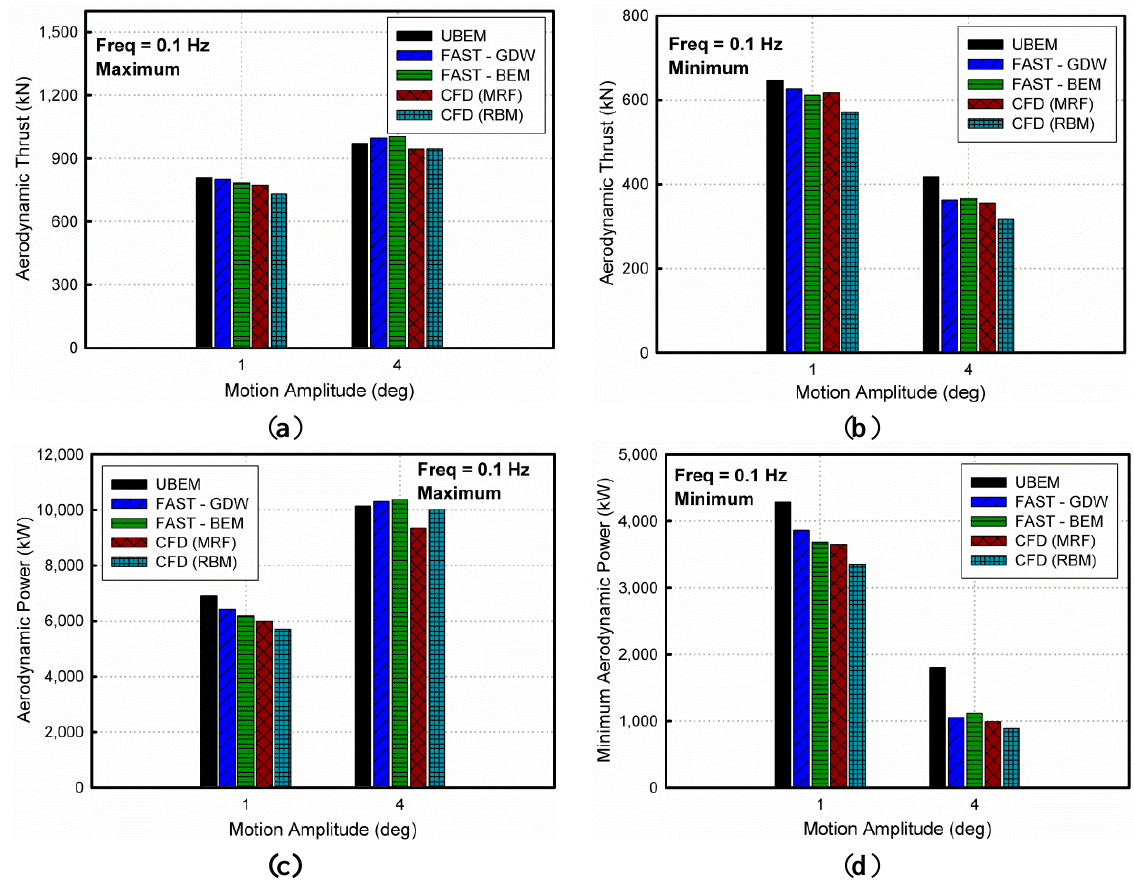
Figure 9. Aerodynamic comparisons using the UBEM, CFD and FAST (NREL) methods for different pitching amplitudes of a FOWT (Freq = 0.1